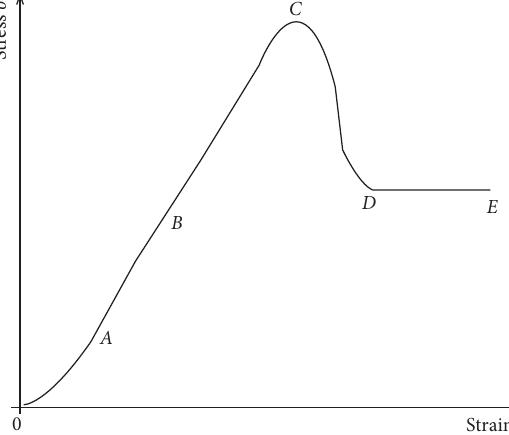
Figure 6: Typical whole stress-strain curve under triaxial